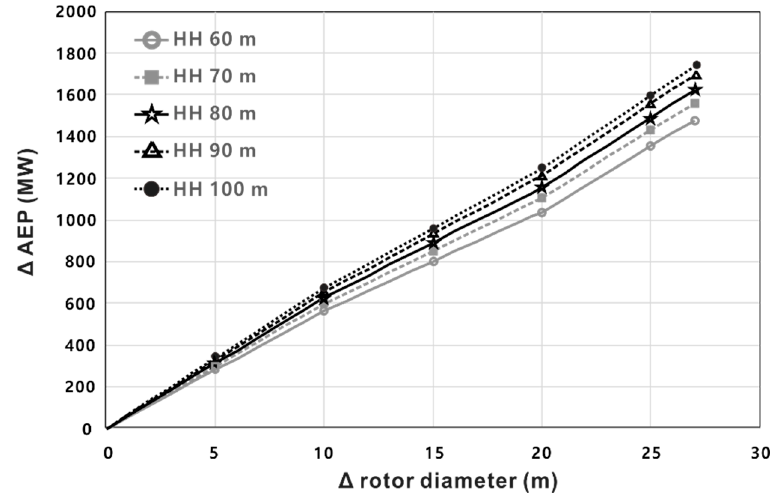
Figure 8. Increment of annual energy production (AEP) with increment of rotor diameter at different hub heights.